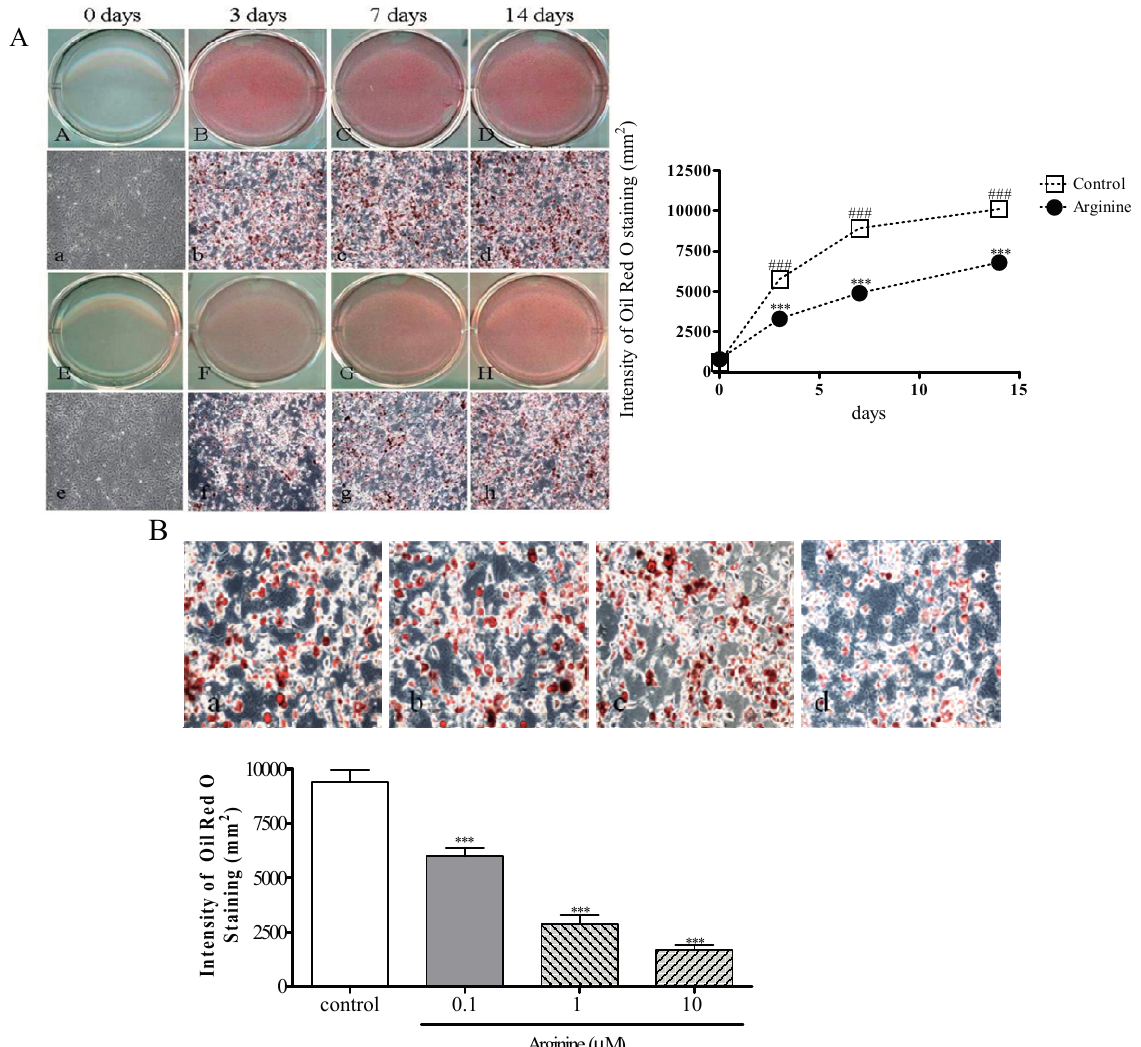
Figure 3. Effect of arginine on adipogenic differentiation in MSCs. ( A ) Temporal effect of arginine on lipid accumulation. MSCs cultured in growth medium were used as the control ( A , a , E , e ), 3 days ( B , b ), 7 days ( C , c ), and 14 days ( D , d ) in differentiation medium or containing 1 μ M arginine for 3 days ( F , f ), 7 days ( G , g ), and 14 days ( H , h ). Cells were fixed with 10% formalin and subjected to Oil red O staining. The line graph shows the intensity of Oil red O staining; ( B ) Dose-dependent effect of arginine on lipid accumulation. The bar graph shows the intensity of Oil red O staining; ( C – D ) The effect of arginine on TG deposition and DNA content. The cellular TG content was measured at 550 nm using a TG-determination kit ( C ), and DNA content of cells was determined as an internal control ( D ); ( E ) The mRNA expression of PPAR γ , CEB/P α , and Fabp4 transcription factors. The expression levels of all genes were measured using qRT-PCR and normalized relative to the level of β -actin expression. Fold-differences were calculated as the relative expression as compared with the expression in control cells. The results are representative of three other experiments, and each bar represents the mean ± S.E.M. ### p < 0.001 compared with 0 days; * p < 0.05 and *** p < 0.001 compared with control.; n.s., nonsignificant difference compared with